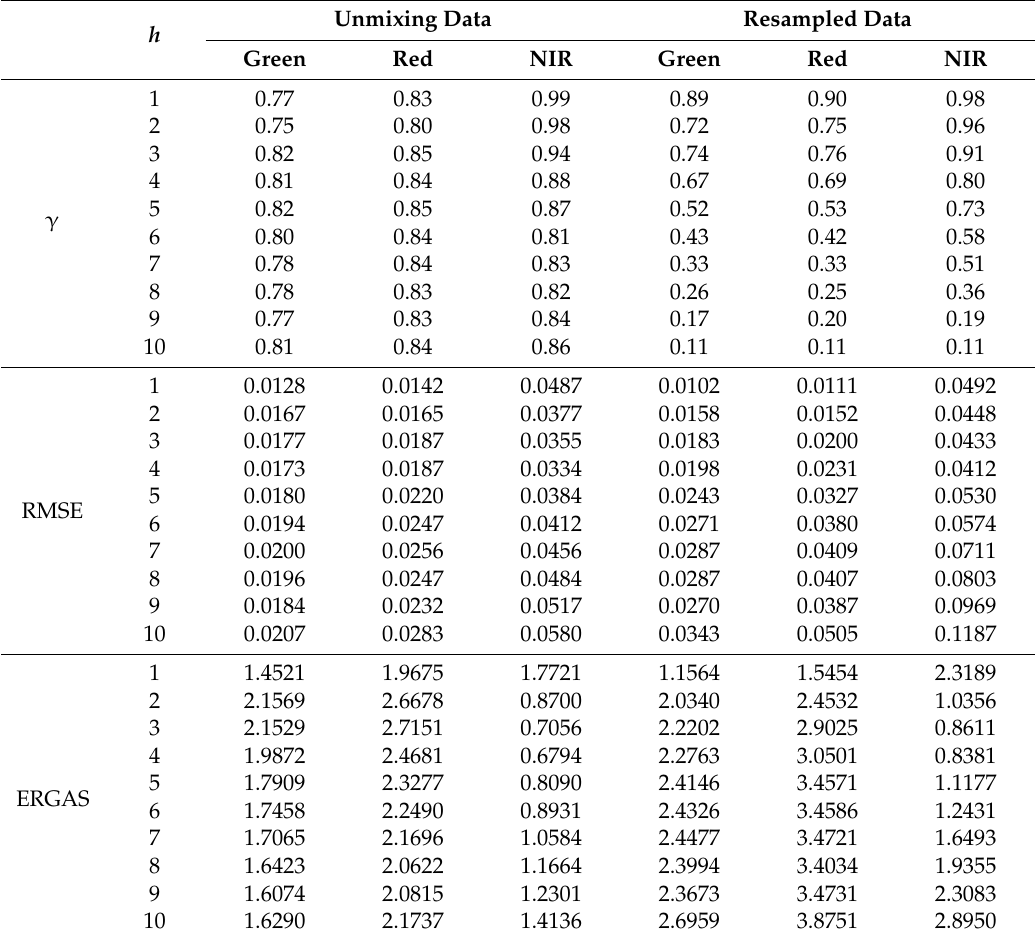
Table 4. The relationship of data generated from the unmixing method and resampled data to the reference data at different heterogeneity levels ( h